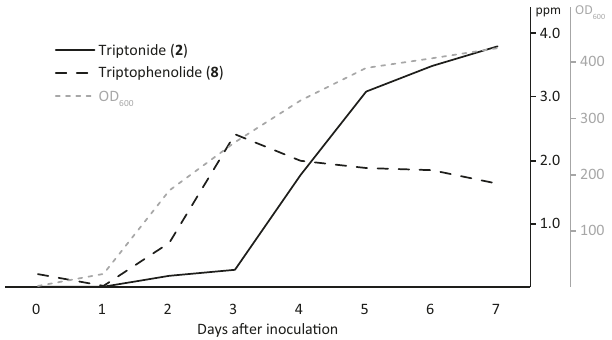
Fig. 3 | Accumulation in fed-batch fermentation. The accumulation of 8 (dotted black) and 2 (solid black) from NVJ8.5 (Supplementary Table 28) grown in a fed- batch fermentation. Density of the S. cerevisiae culture was based on the optical density of daily culture